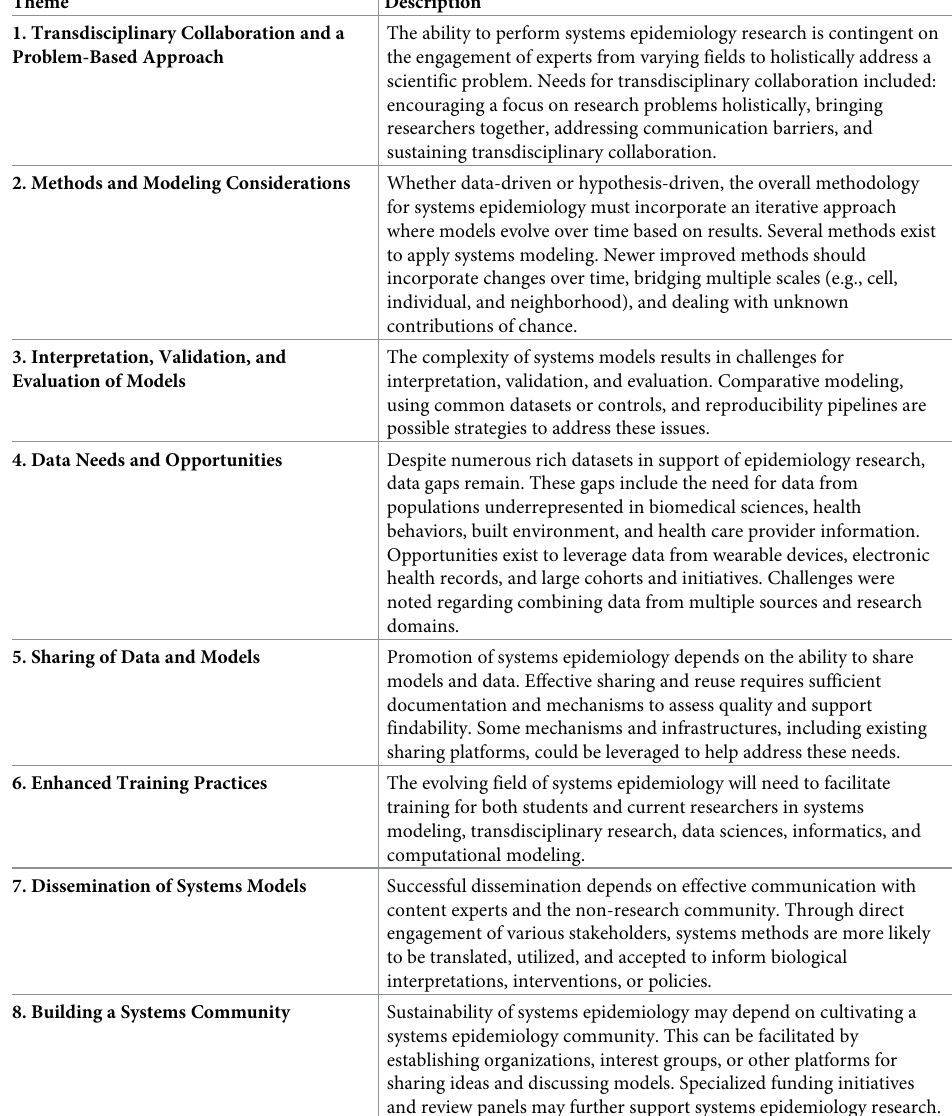
Table 1. Major themes identified to advance systems epidemiology